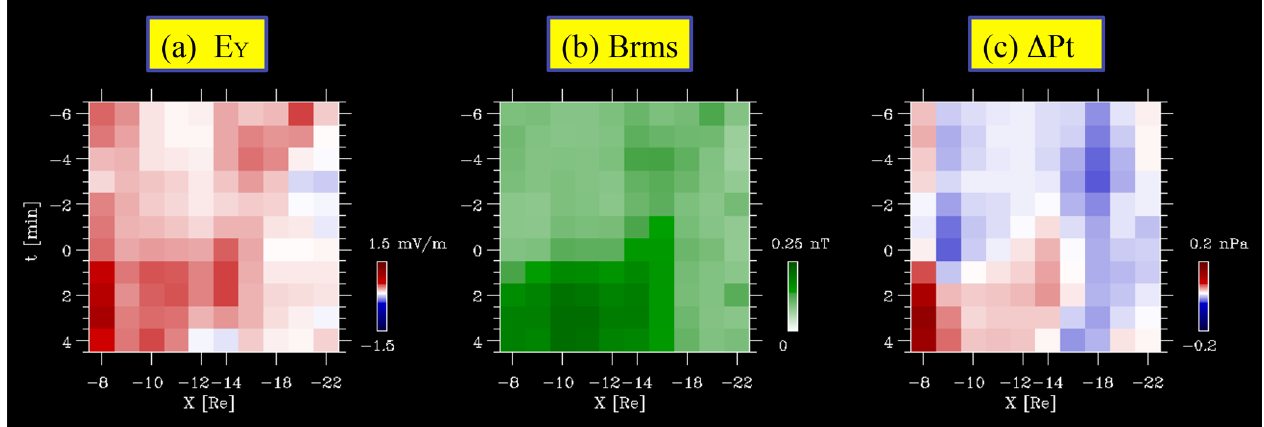
Fig. 8. As for Fig. 6, but for (a) the duskward electric field, E Y ; (b) the root-mean-square value of the magnetic field, B rms ; and (c) the deviation of total pressure, 1P t , in the equatorial